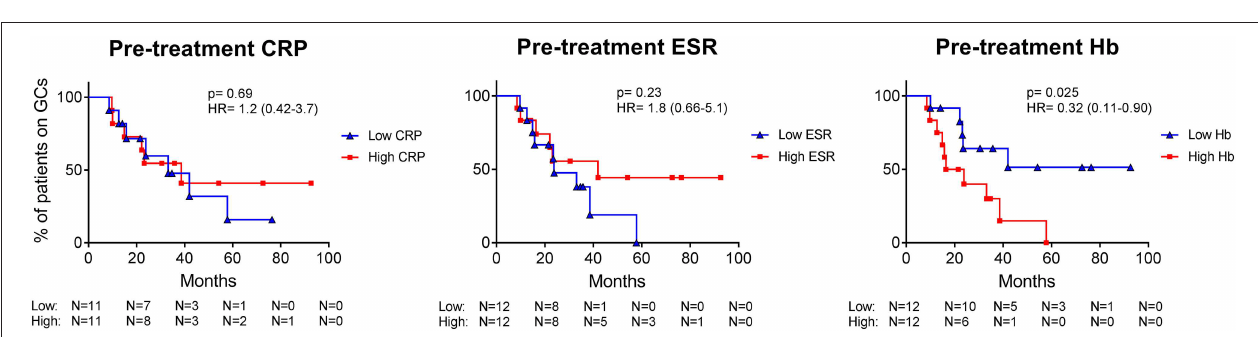
FIGURE 6 | Different leukocyte subset counts and inflammatory markers in treatment- free remission. Leukocyte subset counts pre-treatment and in treatment-free remission (A: GCA n = 13 patients, 17 samples and B: PMR n = 15 patients, 25 samples) were expressed as median fold-change compared to healthy controls. † : sign difference between HC and treatment-free remission. × : sign difference between pre-treatment and treatment-free remission (Mann-Whitney U -test p < 0.05). (C) Inflammatory markers in HC, GCA treatment-free remission, and PMR treatment-free remission (Mann-Whitney U -test: *** p < 0.001,**** p < 0.0001). Data is expressed as median and interquartile range. (D) Correlation between B-cell counts and ESR in treatment-free remission patients.